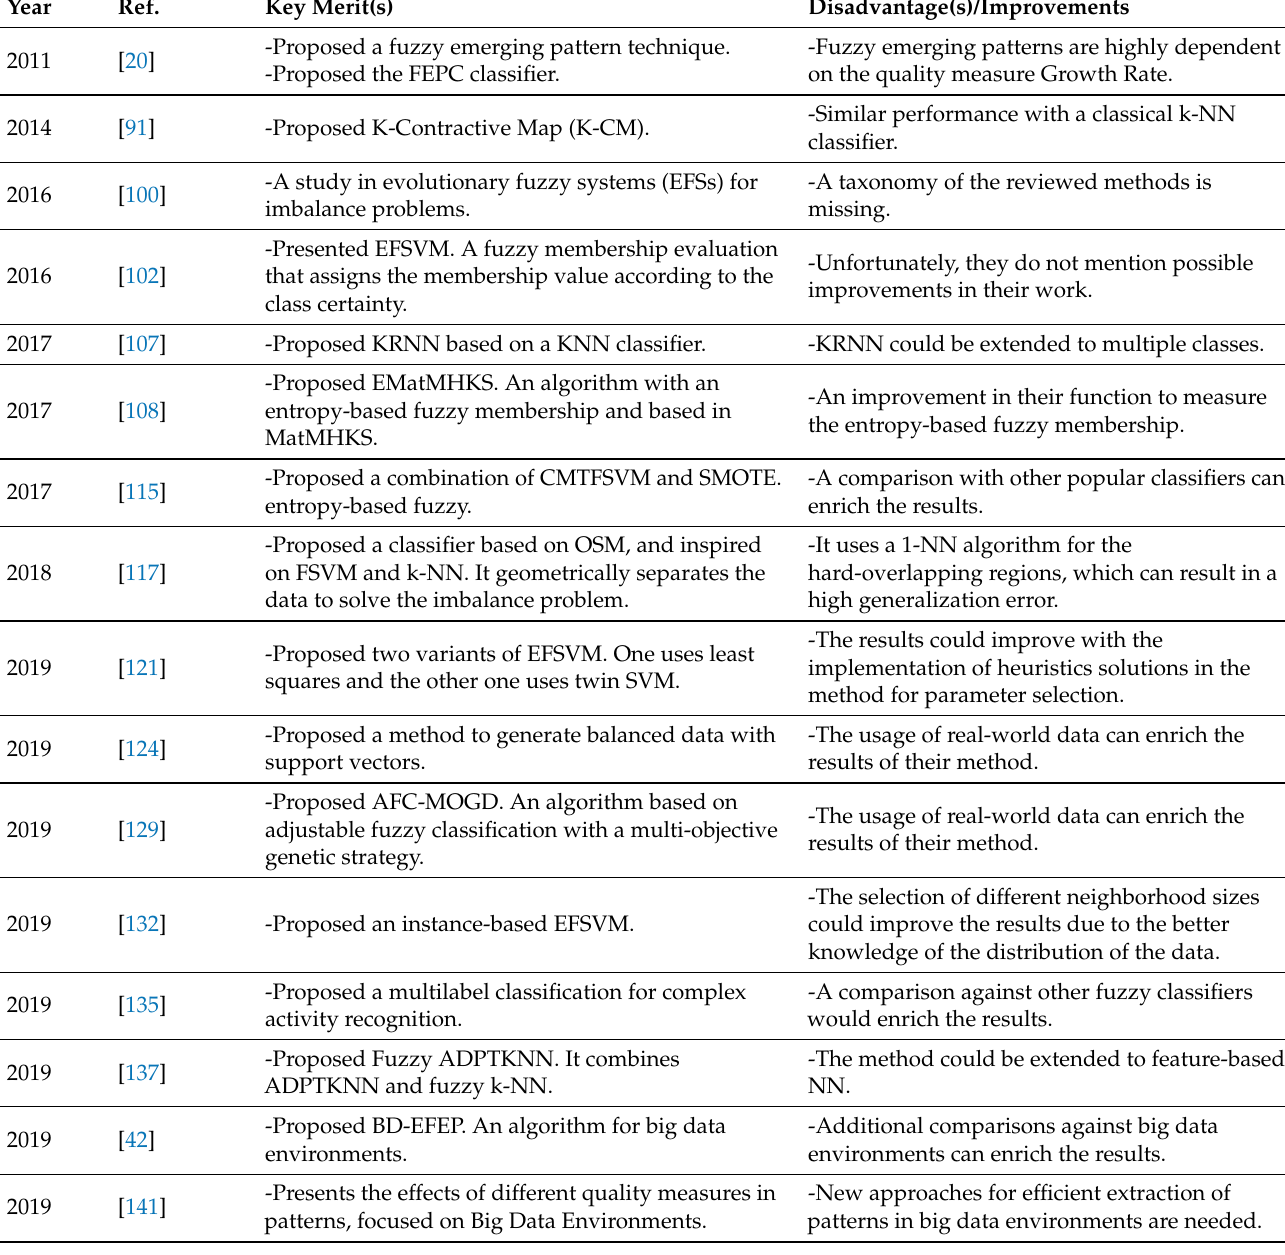
Table 1. Algorithm-level approaches with their key merit(s) and